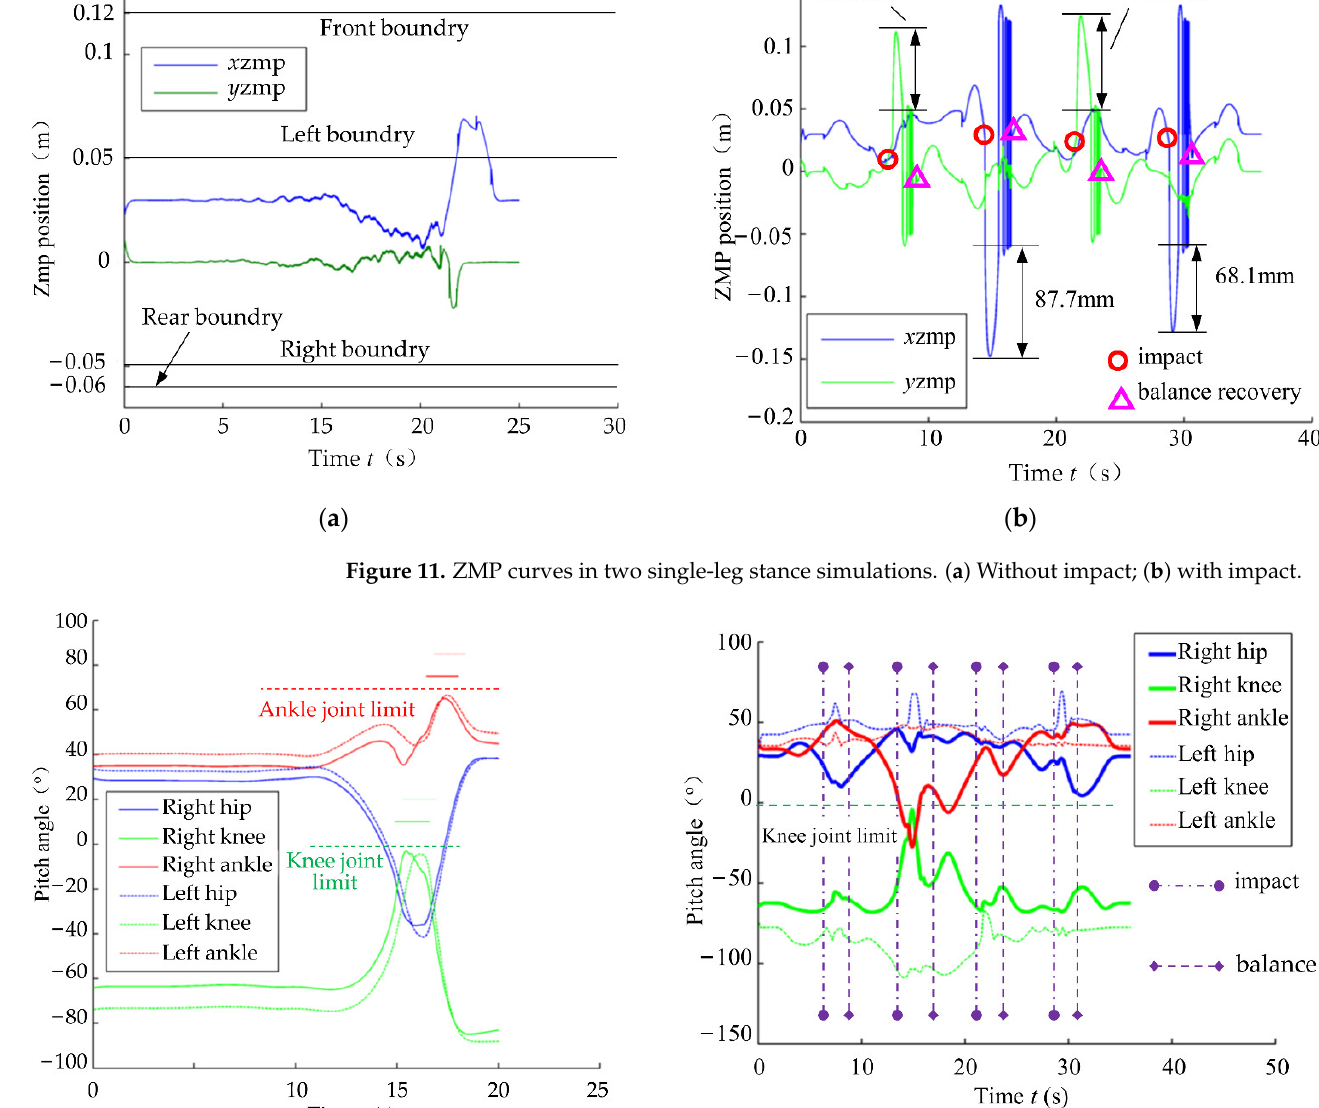
Figure 12. Pitch angles from two single-leg stance simulations. ( a ) Without impact; ( b ) with impact.